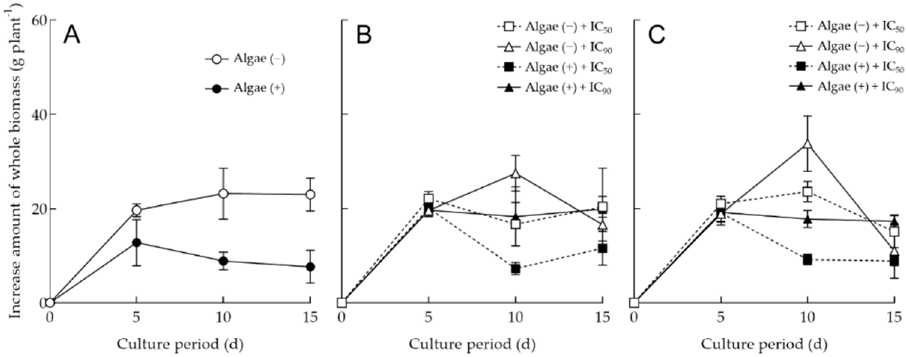
Figure 5. The growth of perilla cultured in algae-free and -treated hydroponic media with ( A ) non- treatment, ( B ) rose leaf, and ( C ) walnut husk extracts for 15 days.